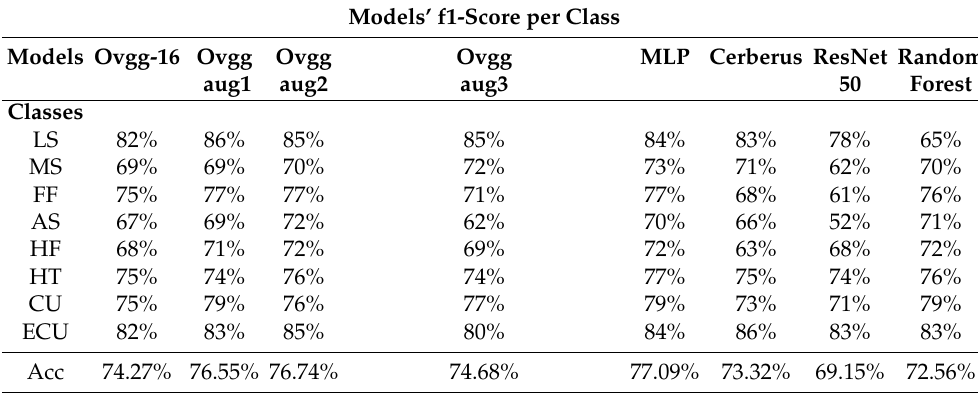
Table 21. f1-score per class and accuracy of different